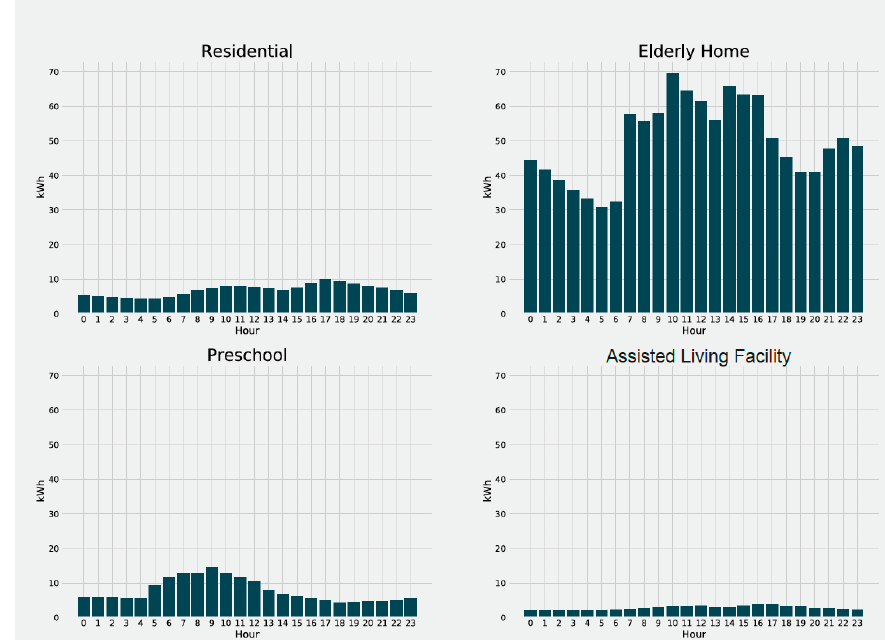
Figure 7. Consumption profiles of the different figures scaled to the same y -axis, showing the disparity between the consumption of the elderly home and that of the other buildings. The magnitude of this difference has two consequences. First, combining these sets of buildings into a microgrid would generate a collective profile that largely resembles that of the elderly home. The extreme difference between the consumption levels of the elderly home and those of the remaining buildings ensures that the elderly home’s profile would “dominate” the others in a microgrid. Secondly, combining the buildings into a